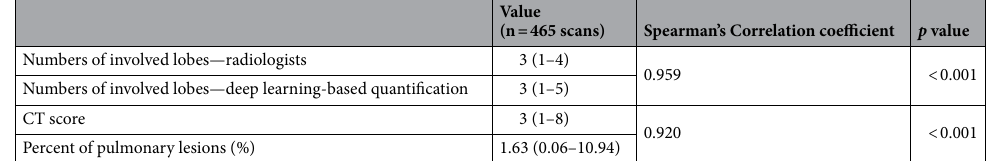
Table 3. Estimations of Spearman’s correlation between CT scoring and deep learning-based quantification. Controlling for the variable of "time from symptom onset (d)".